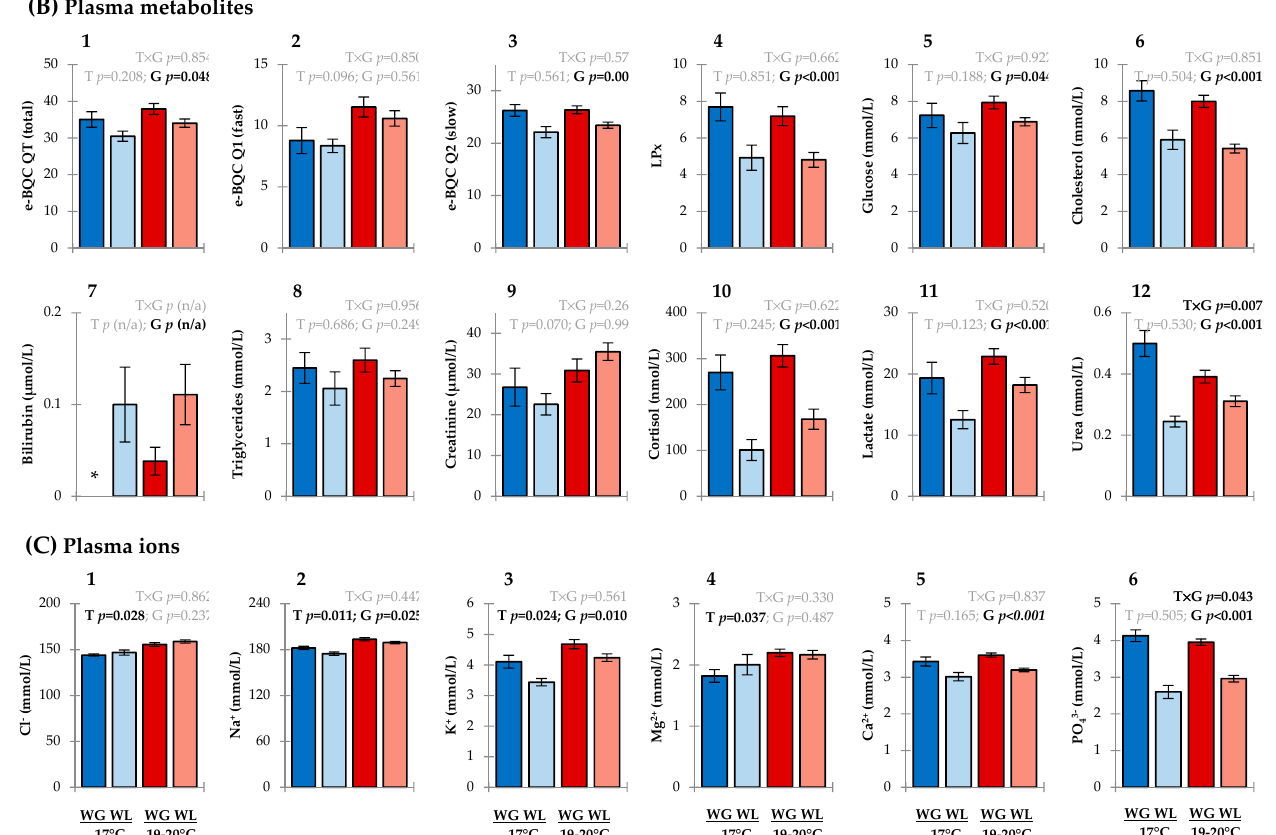
Figure 3. Plasma-based biochemical parameters associated with chronic thermal stress (17 ◦ C vs. 19–20 ◦ C) and growth performance (weight gain (WG) vs. weight loss (WL) phenotypes) in Oncorhynchus tshawytscha . ( A ) Protein parameters; ( B ) Metabolite parameters; ( C ) ion parameters. Data represent the group means ± SE. Blue and red bars represent 17 ◦ C and 19–20 ◦ C treatments, respectively; darker and lighter shaded bars represent groups that gained and lost weight, respectively. Main effects of temperature (T), growth (G), and their interaction (T × G) are presented via their p -values in the upper section of each plot (generalized linear mixed models; α = 0.05). Asterisks signify non-detectable levels (statistical testing of these parameters are not applicable (n/a)).